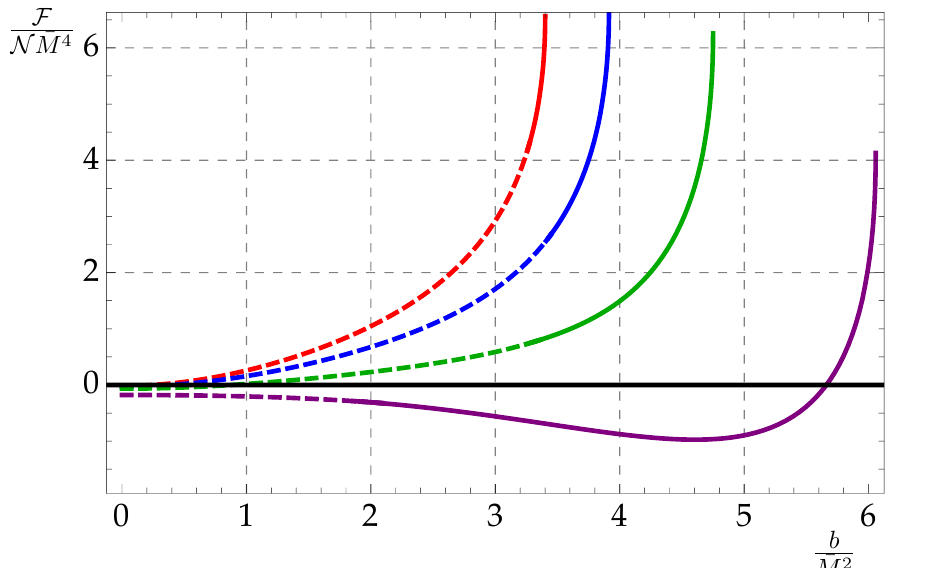
Figure 9 . Free energy F = N (cid:22) M 4 as a function of b= (cid:22) M 2 . Red, blue, green, and purple curves (top to bottom) correspond to T= (cid:22) M = f 0 : 55 ; 0 : 59 ; 0 : 65 ; 0 : 734 g respectively. The dashed segments correspond to Minkowski embeddings, while the continuous segments correspond to black hole